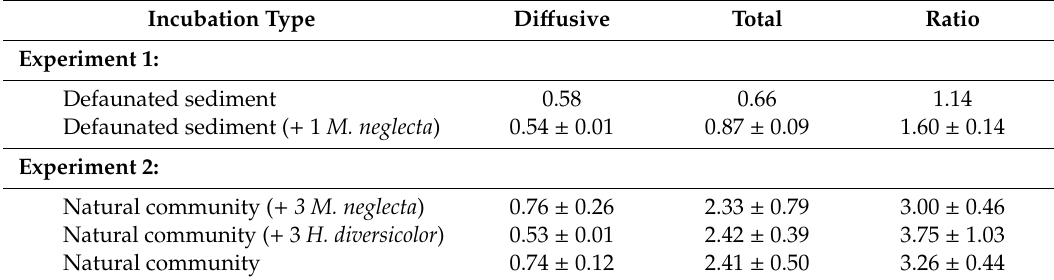
Table 2. Di ff usive and total bromide fluxes (mmol m − 2 h − 1 ) calculated for di ff erent incubations (runs) in two